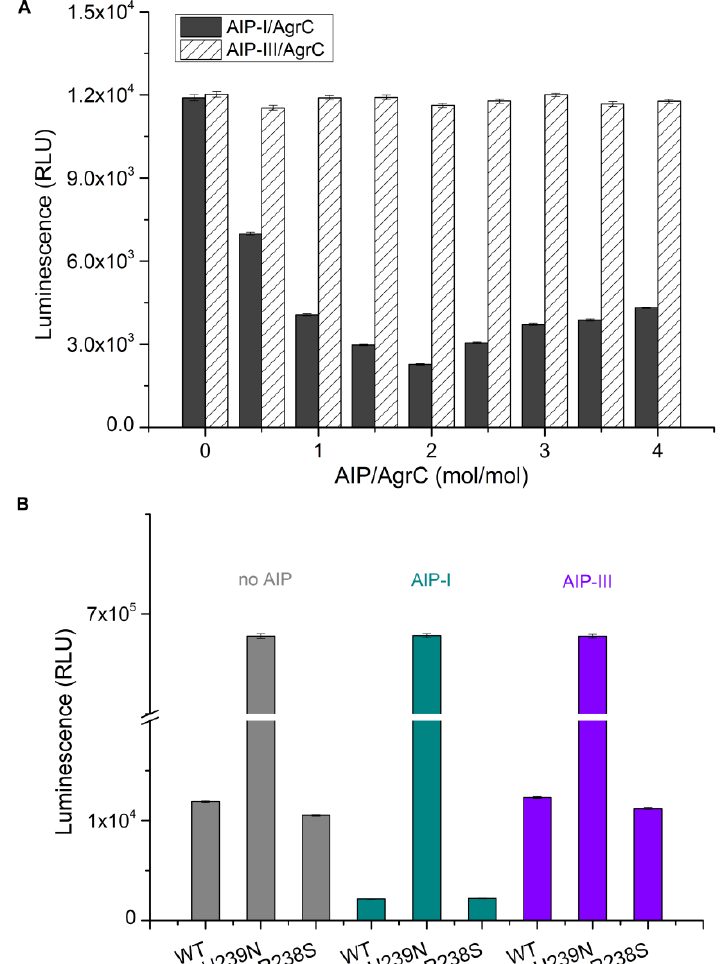
Figure 4. Effect of the AIP-I and AIP-III on the autophosphorylation of AgrC and AgrC mutants. Each autophosphorylation reaction contained 100 µg of purified AgrC or AgrC mutant that had been preincubated in 50 μ L of reaction buffer in the presence or absence of AIP-I or AIP-III. After 20 min of kinase reaction, an equal volume of Kinase-Glo kit reagent was added. Luminescence was recorded on a Synergy2 Multi-Mode Microplate Reader. ( A ) AgrC autophosphorylation levels in response to increasing concentrations of AIP-I or AIP-III; ( B ) AgrC mutant autophosphorylation levels with or without AIP-I or AIP-III. Values represent independent